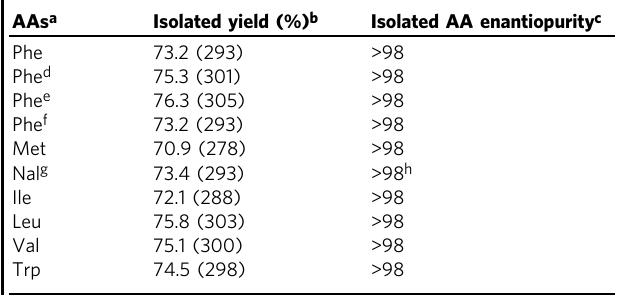
Table 1 Isolated yields and enantiopurity obtained over four EECR cycles with ( R )-5 (see details in Supplementary information, Sections 6.3.3 –